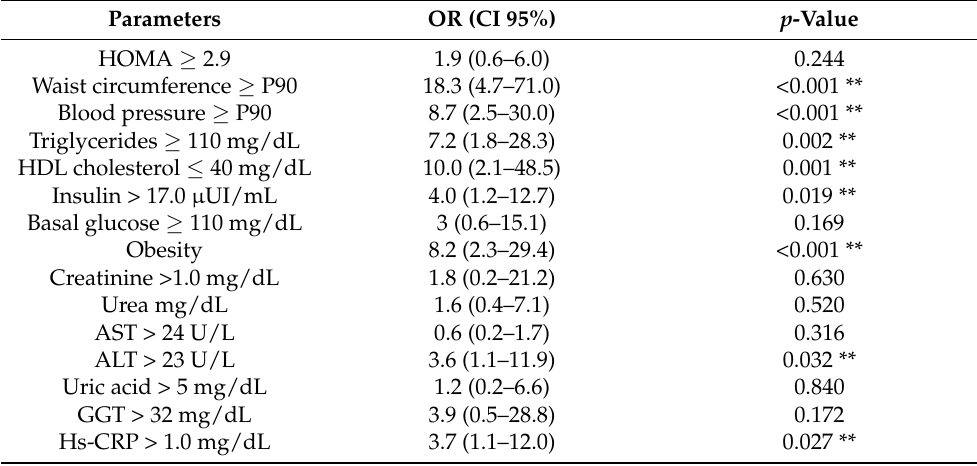
Table 6. Estimation of odds ratios (OR) for metabolic syndrome by NCEP—ATP